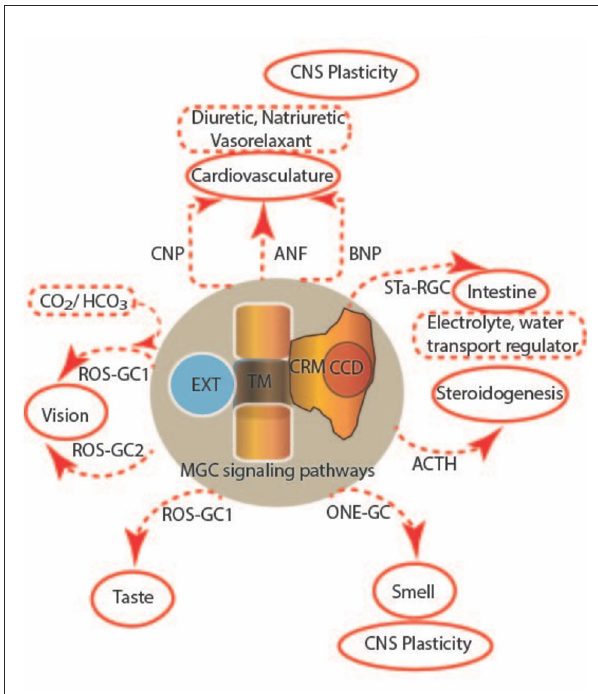
FIGURE1 Multi-limbed membrane guanylate cyclase signaling. Seven subfamily forms of membrane guanylate cyclases, encoded by distinct genes, perform a multitude of functions. These uniquely designed surface receptors are all single-pass transmembrane proteins that detect hormones and other extracellular chemicals at an extracellular domain (EXT), translate the signal across a transmembrane domain (TM) to a catalytic regulatory module (CRM) and a catalytic core domain (CCD) to regulate cGMP synthesis. Together, they control steroidogenesis, cardiovasculature, sensory neurons in vision, taste and smell, the intestine, skeletal growth, and CNS